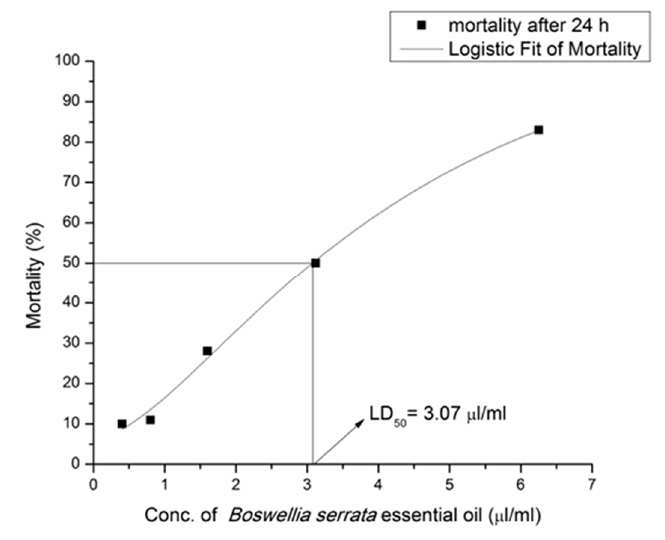
Figure 1. Relationship between mortality (%) and B. serrata EO concentration (µL/mL) after 24 h. Mortality after 24 h ( ■ ), logistic Fit of Mortality (–––) and LD 50 = 3.07 µL/mL.